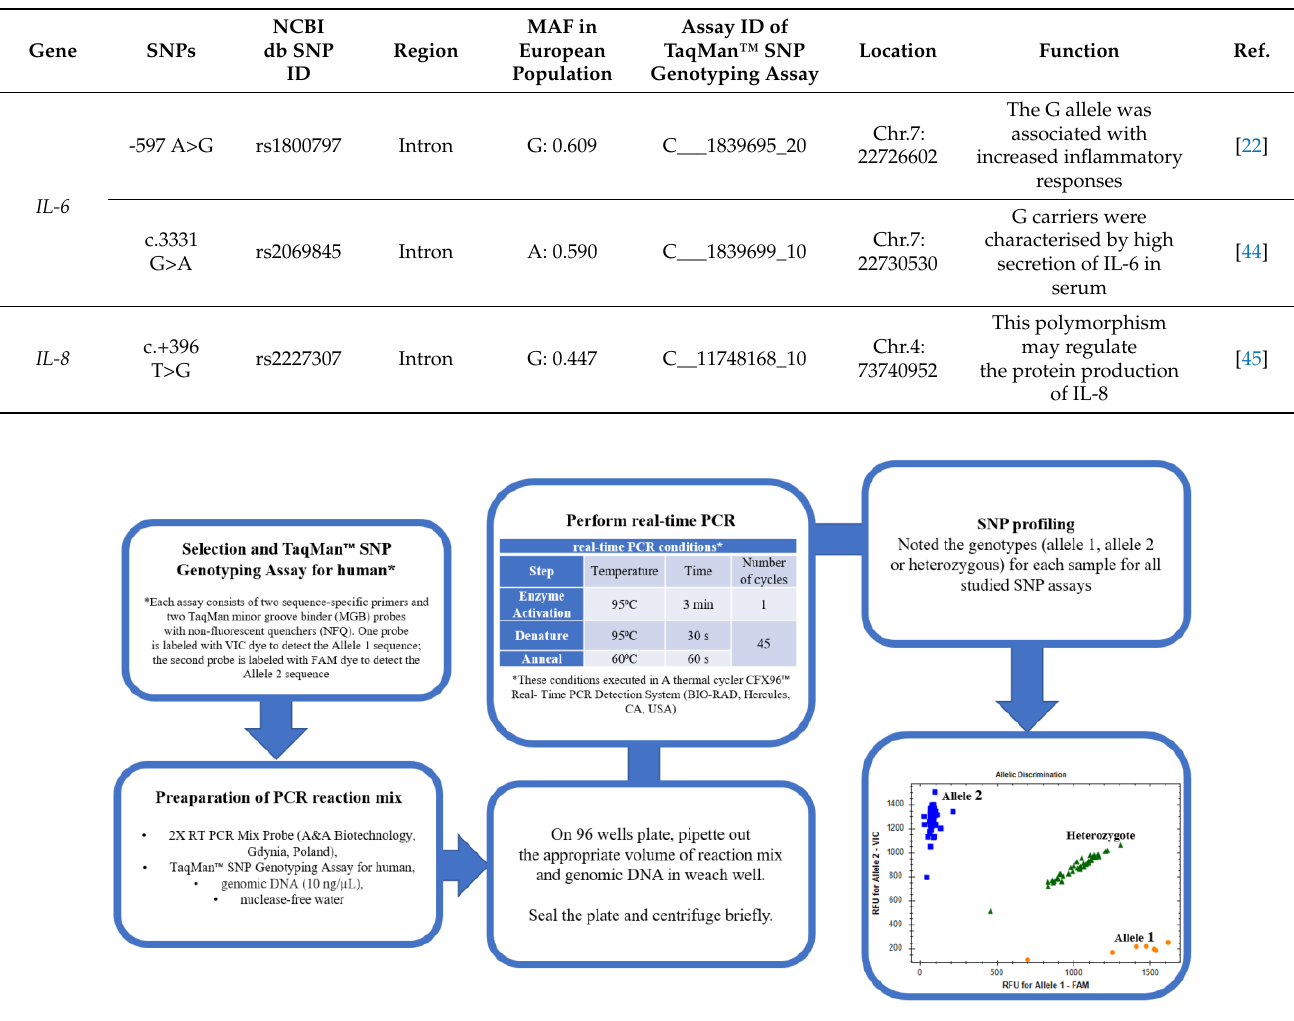
Figure 10. Detailed steps for real-time PCR of SNP profiling.